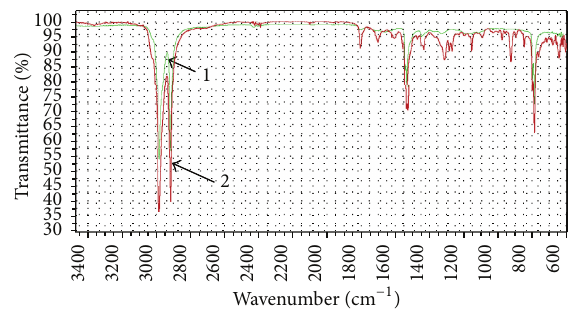
Figure 3: The IR spectra of initial LDPE (1) and received composite containing 85 wt.% LDPE/10wt.% PA-6/5 wt.% EVA type I (2).